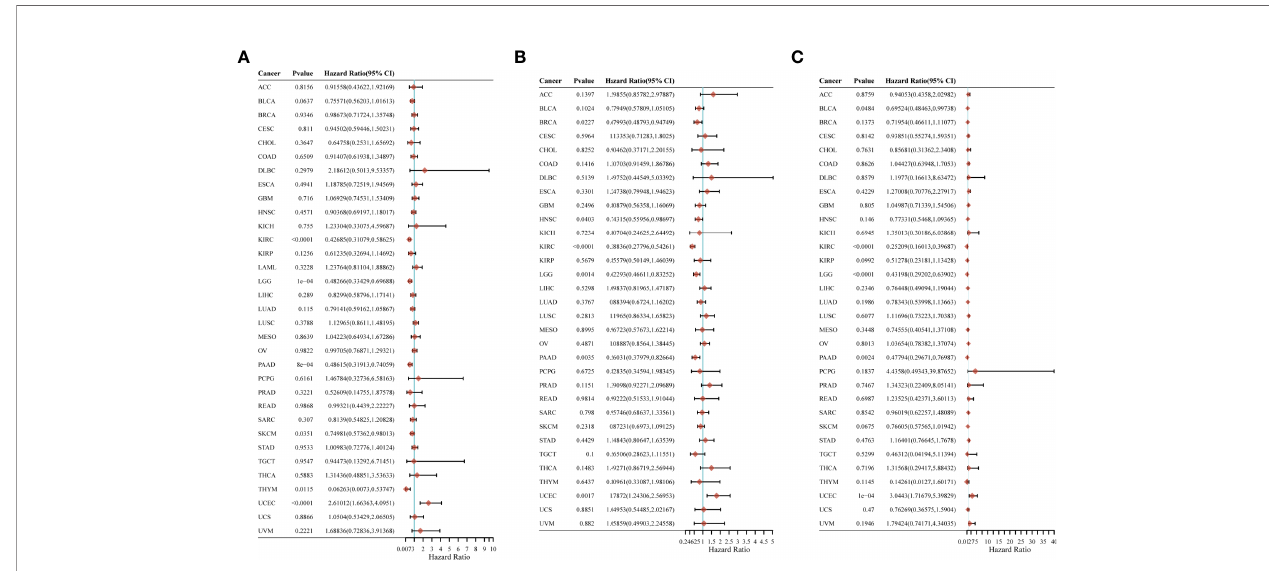
FIGURE 11 | Correlation of CYFIP2 with prognosis in pan – cancer. (A) Cox regression model analysis of the correlation between CYFIP2 expression and OS in various tumors. (B) Cox regression model analysis of the correlation between CYFIP2 expression and PFS in various tumors. (C) Correlation analysis of CYFIP2 expression with DSS in various tumors by Cox regression